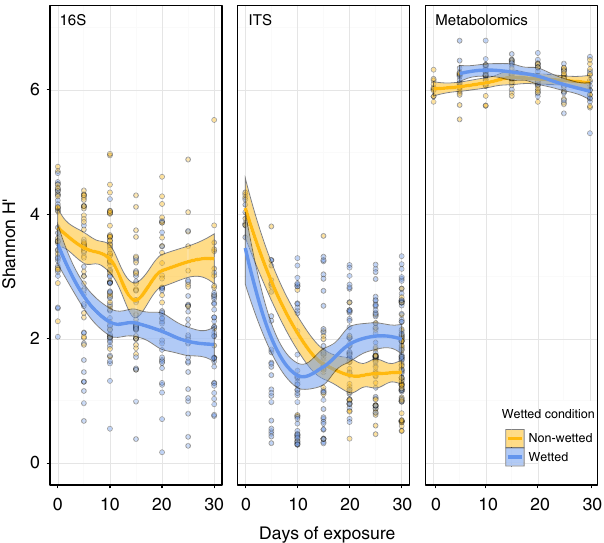
Fig. 2 Change in the Shannon Index of samples over time. Points represent individual samples and the trend lines are a smoothed moving-average of the mean and shaded regions indicate the standard error ( n = 338, 330, and 144 samples for 16S, ITS, and Metabolomics,